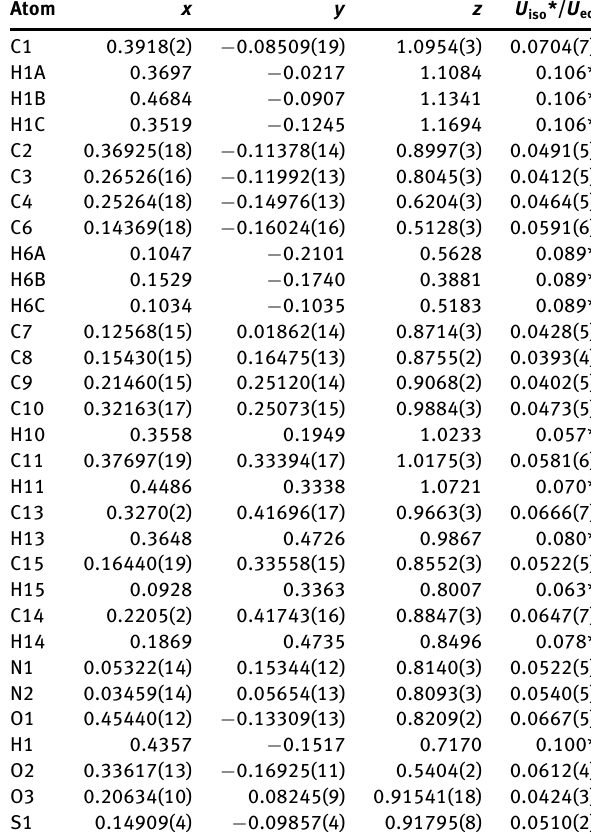
Table 2: Fractional atomic coordinates and isotropic or equivalent isotropic displacement parameters (Å 2